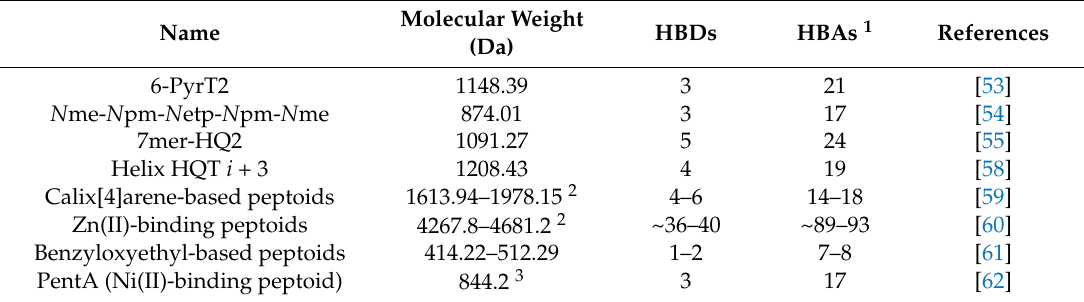
Table 4. Physicochemical properties for example metal-chelating